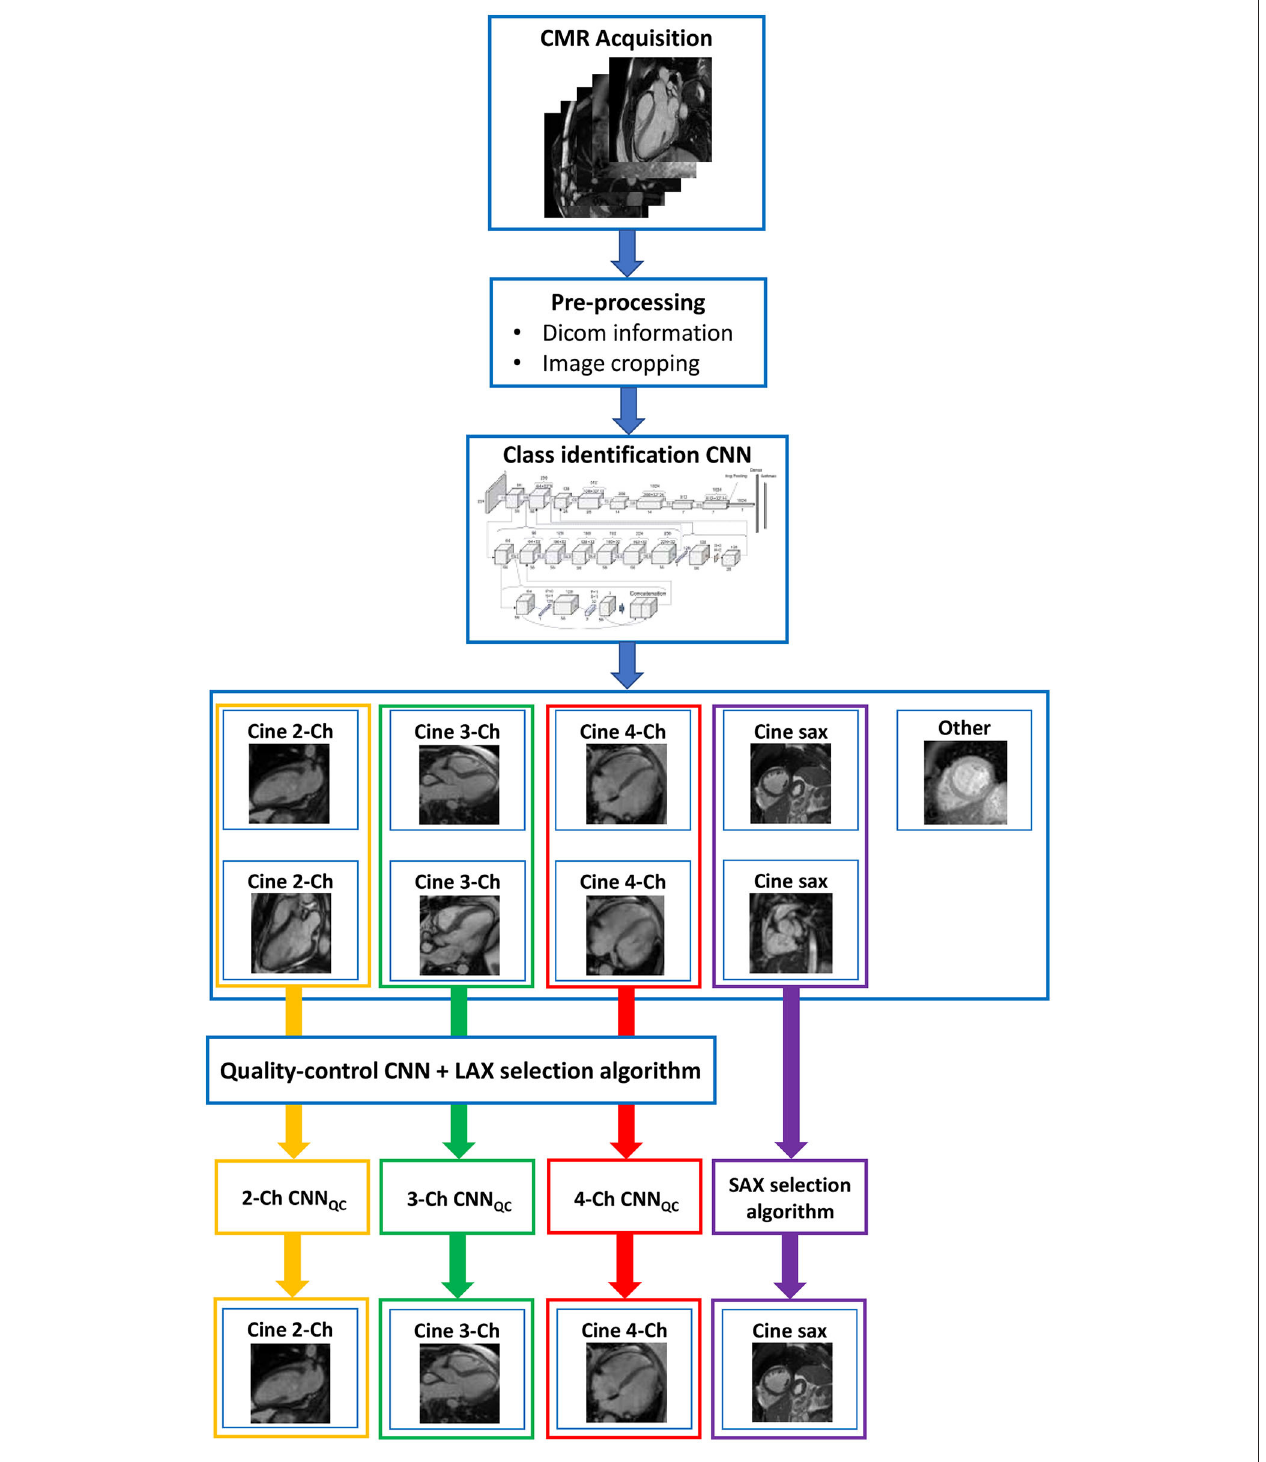
FIGURE 1 | Complete framework. The framework consisted of a first pre-processing step to exclude still images; two sequential convolutional neural networks (CNN), the first to classify images in standard cine views (2/3/4-chamber and short axis), the second to classify images according to image quality and orientation; a final algorithm to select one good image of each class. This construction allows for the framework, presented with a full CMR exam, to perform a quality-controlled selection of one good image for each conventional cine class, which is then used for analysis of cardiac function. Ch, chamber; CNN, convolutional neural network; LAX, long axis; SAX, short axis; QC, quality